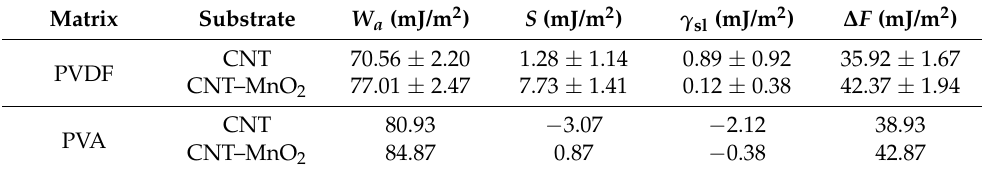
Table 4. Wetting parameters W a , ∆ F , S , and γ sl predicted based on the surface energy components of CNT and CNT–MnO 2 .